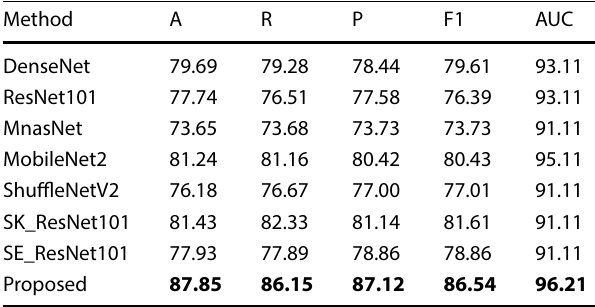
Table 4 Classification performance of the liver dataset